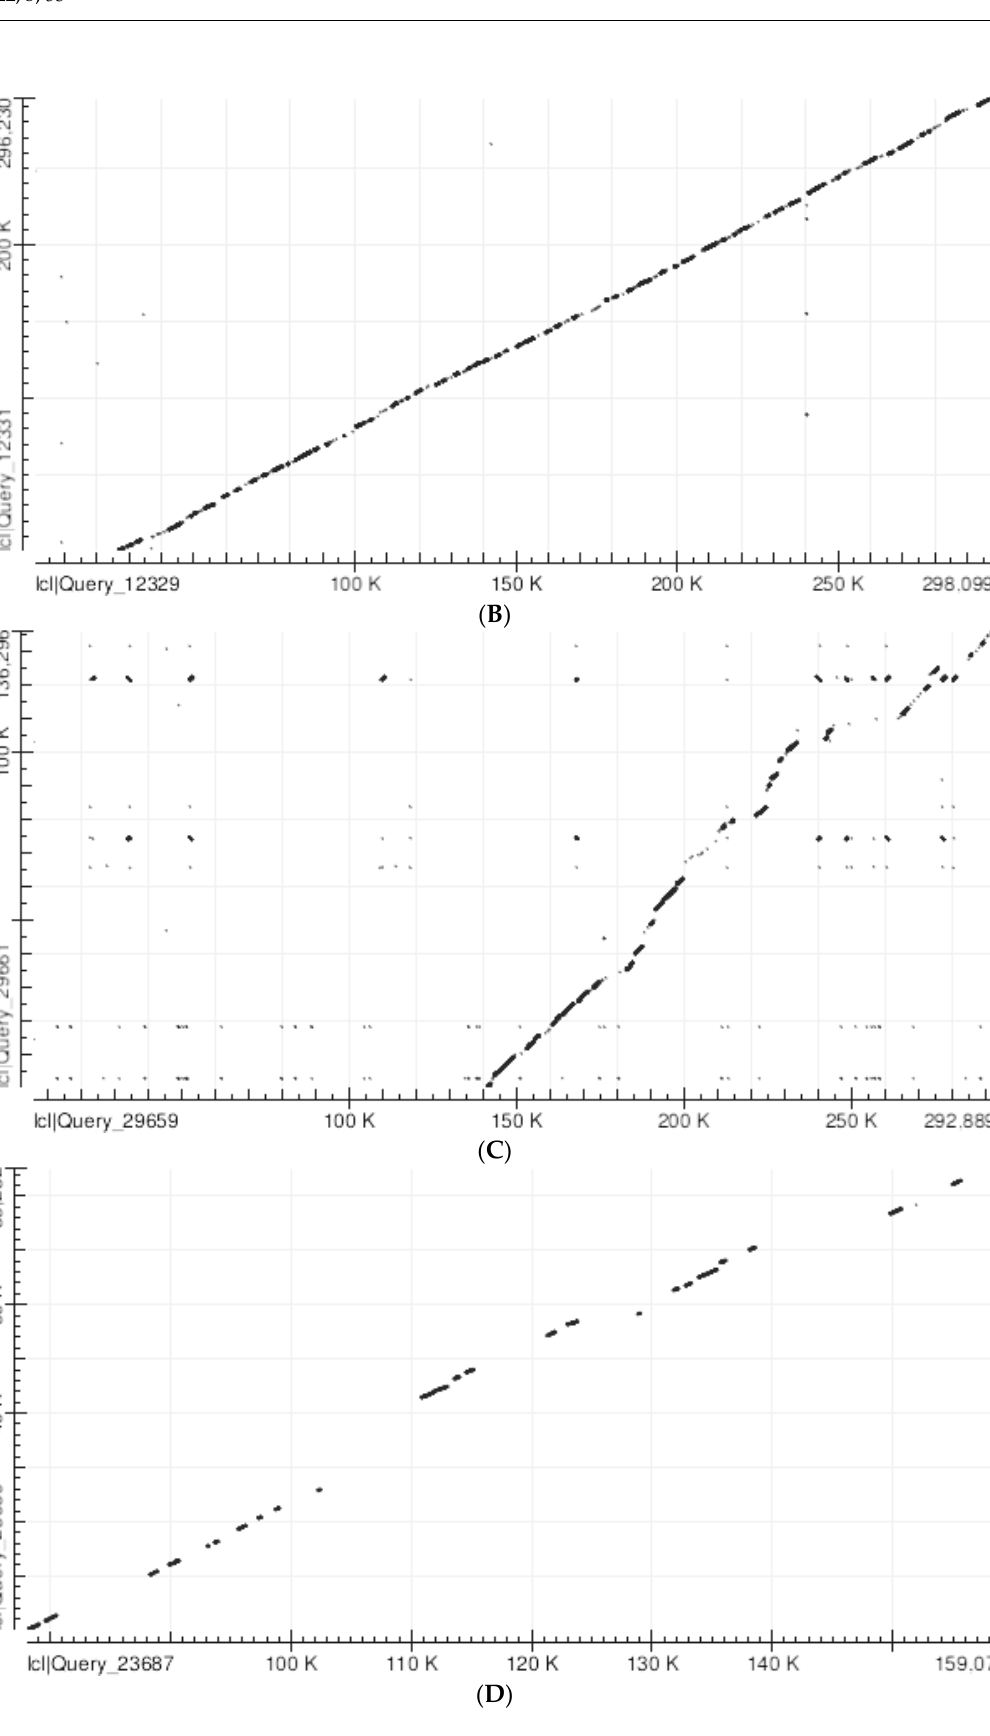
Figure 2. ( A ) Abscissa: Human SLC25A21 (490,793 nucleotides). Ordinate: Mouse slc25a21 (444,514 nucleotides). Number of matches: 1660. Note the significant alignment of most matches along the diagonal from the lower left corner to the upper right corner. The matches which are outside the